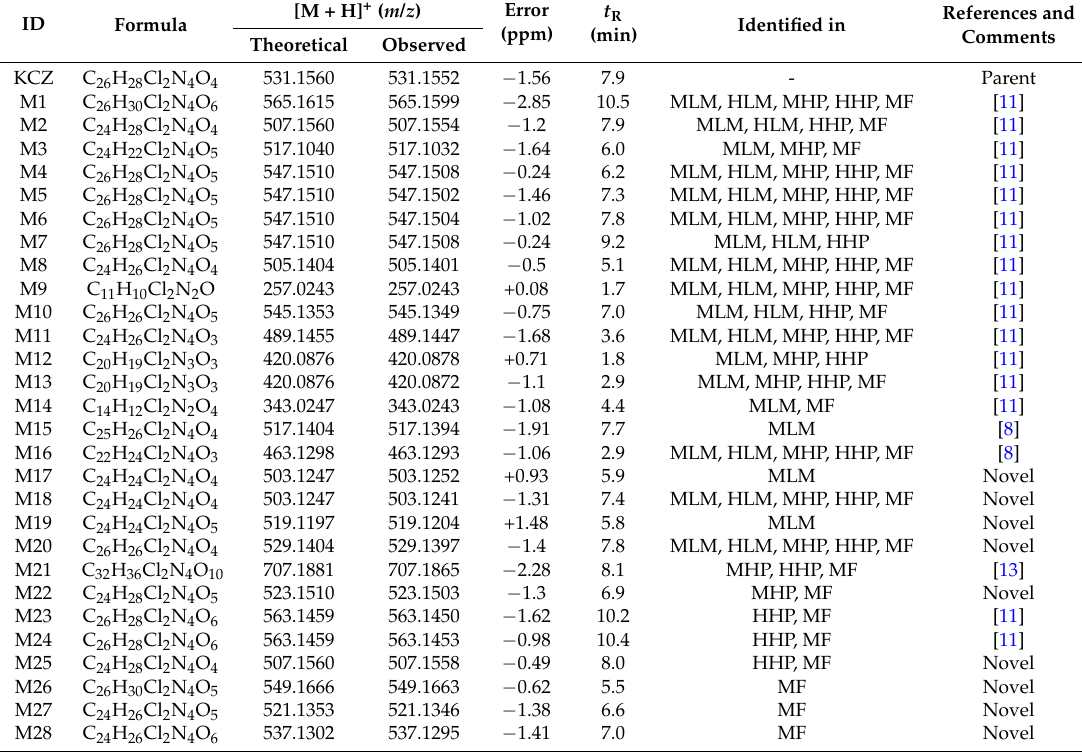
Table 1. Chemical formulae, molecular ions, mass accuracies, retention times, and positive biological samples for ketoconazole and its